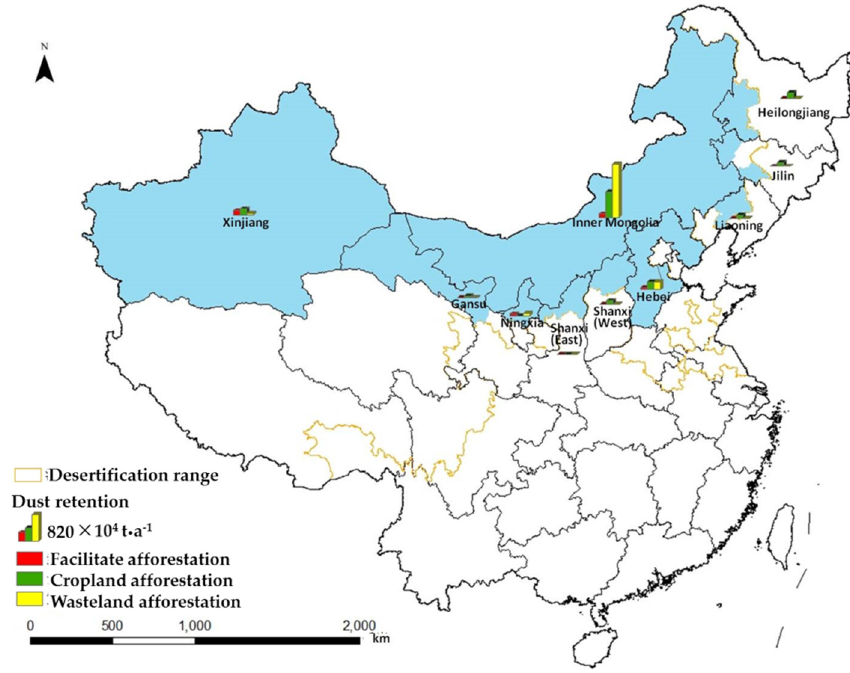
Figure 4. Dust retention by different restoration methods.